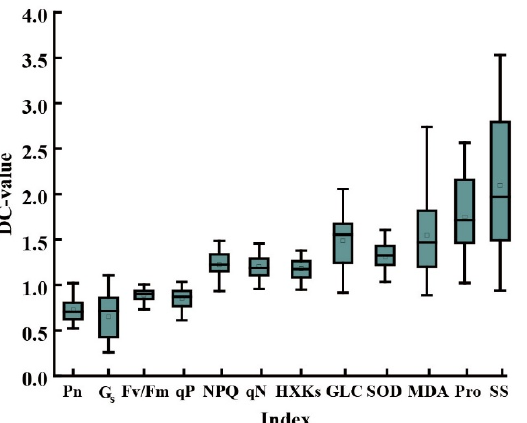
Figure 4. Box plot showing variation in the drought tolerance coefficient for each index.